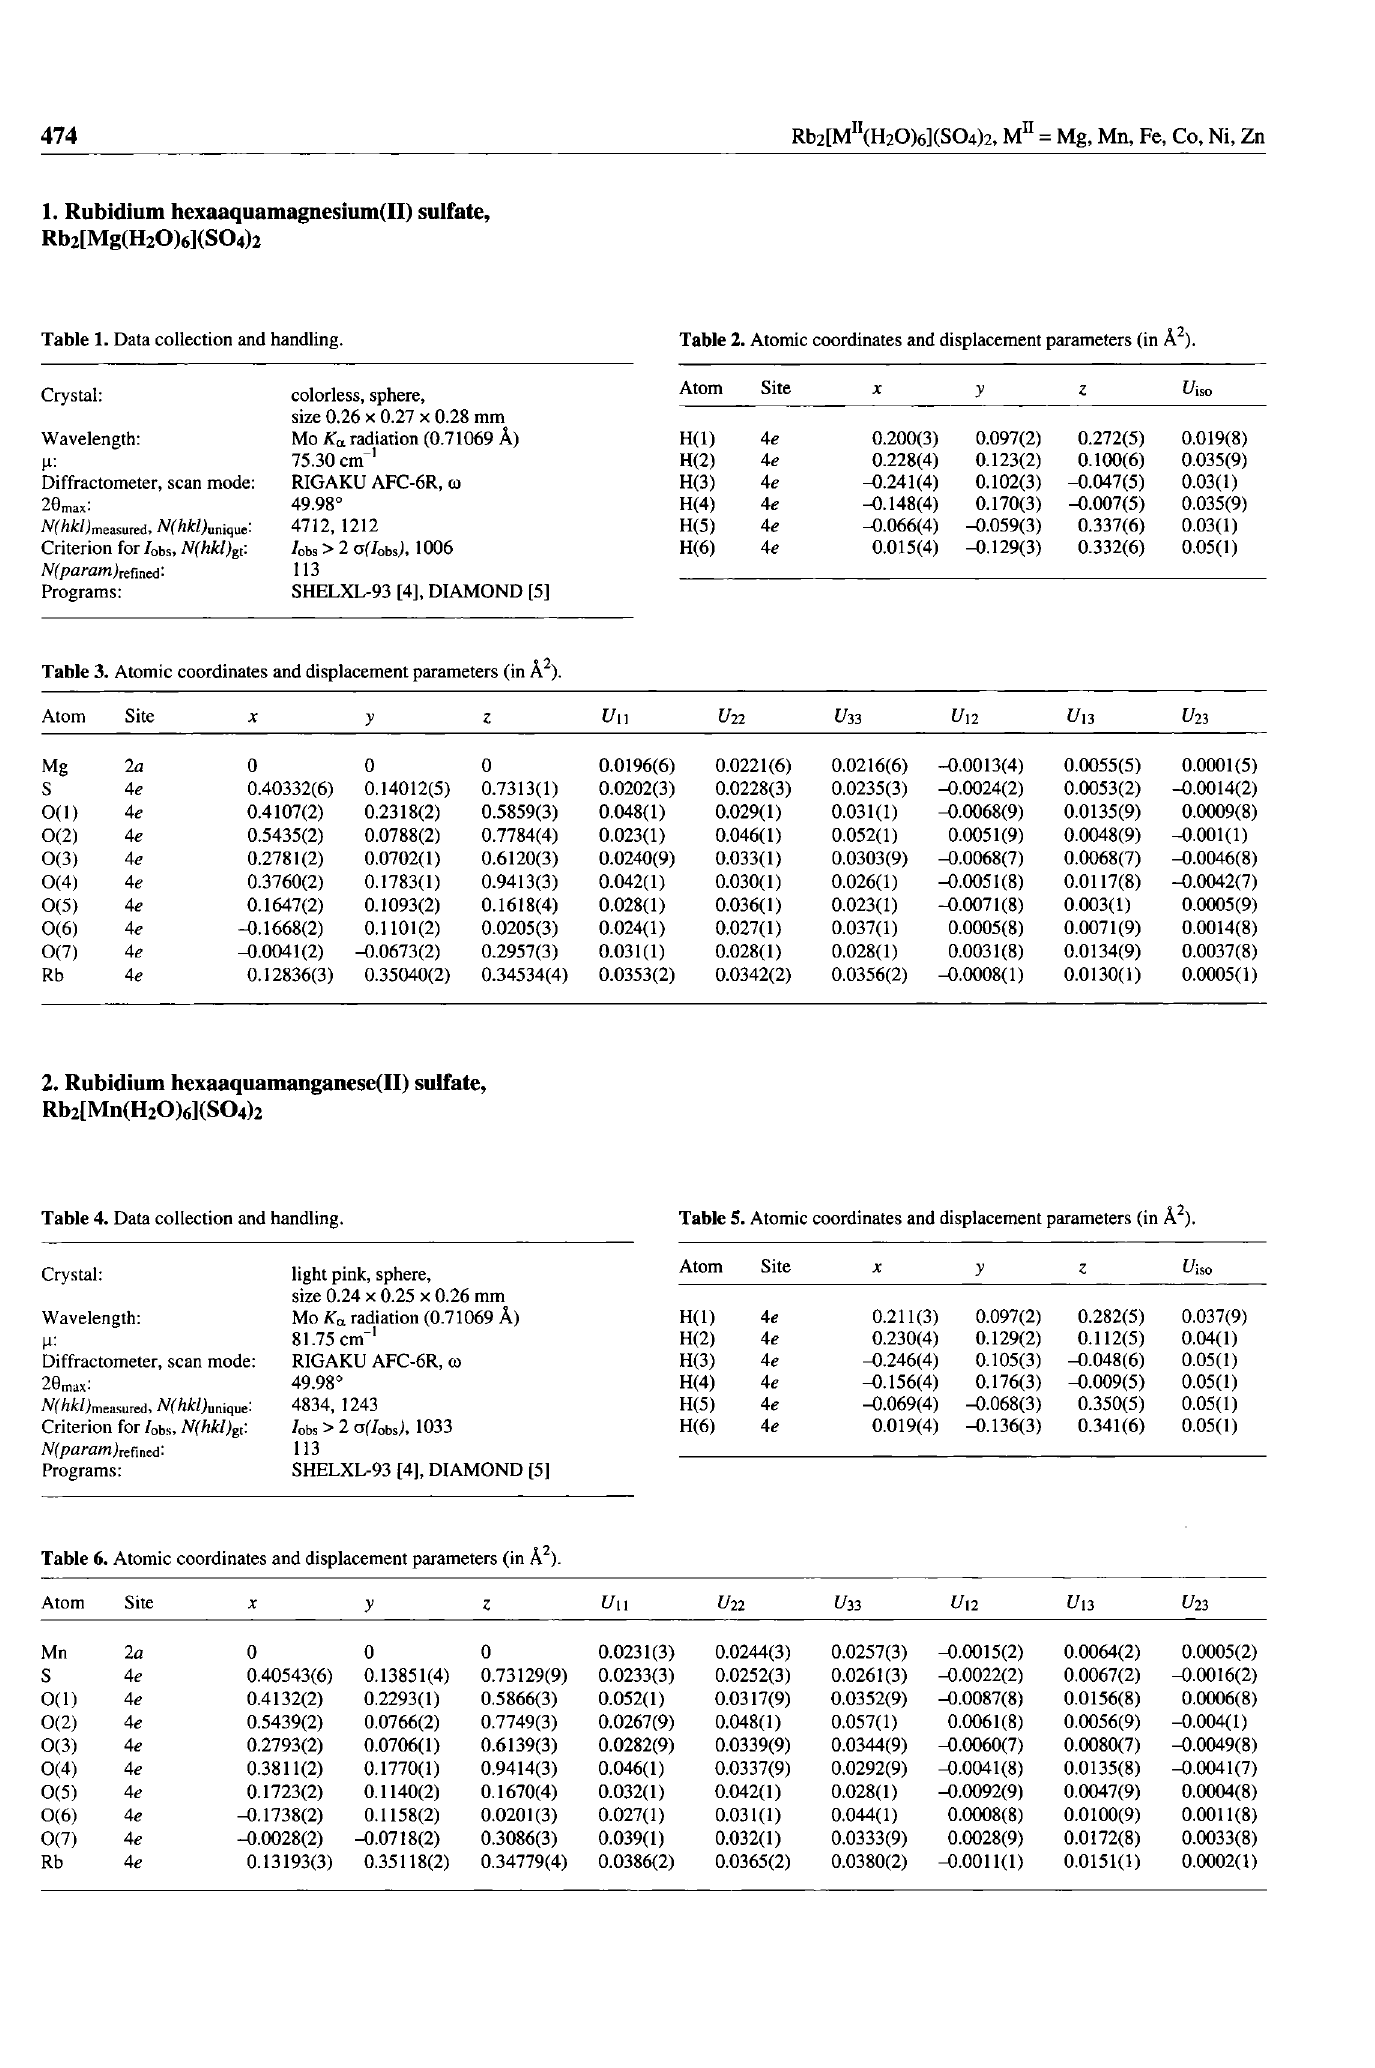
Table 6. Atomic coordinates and displacement parameters (in A 2